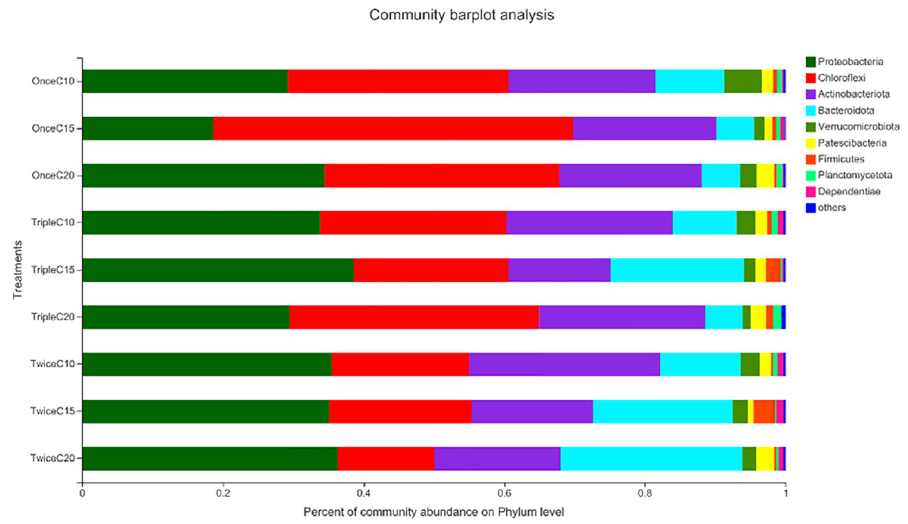
Fig 6. Relative abundance of the most prevalent bacterial phyla identified in the intestine of Litopenaeus vannamei reared in biofloc under different frequent addition times of carbon source (starch) (once, twice, triple) on daily basis and C/N ratios (10, 15, 20). T1; once C/N 10, T2; once C/N 15, T3; once C/N 20, T4; twice C/N 10, T5; twice C/N 15, T6; twice C/N 20, T7; triple C/N 10, T8; triple C/N 15, T9; triple C/N 20.